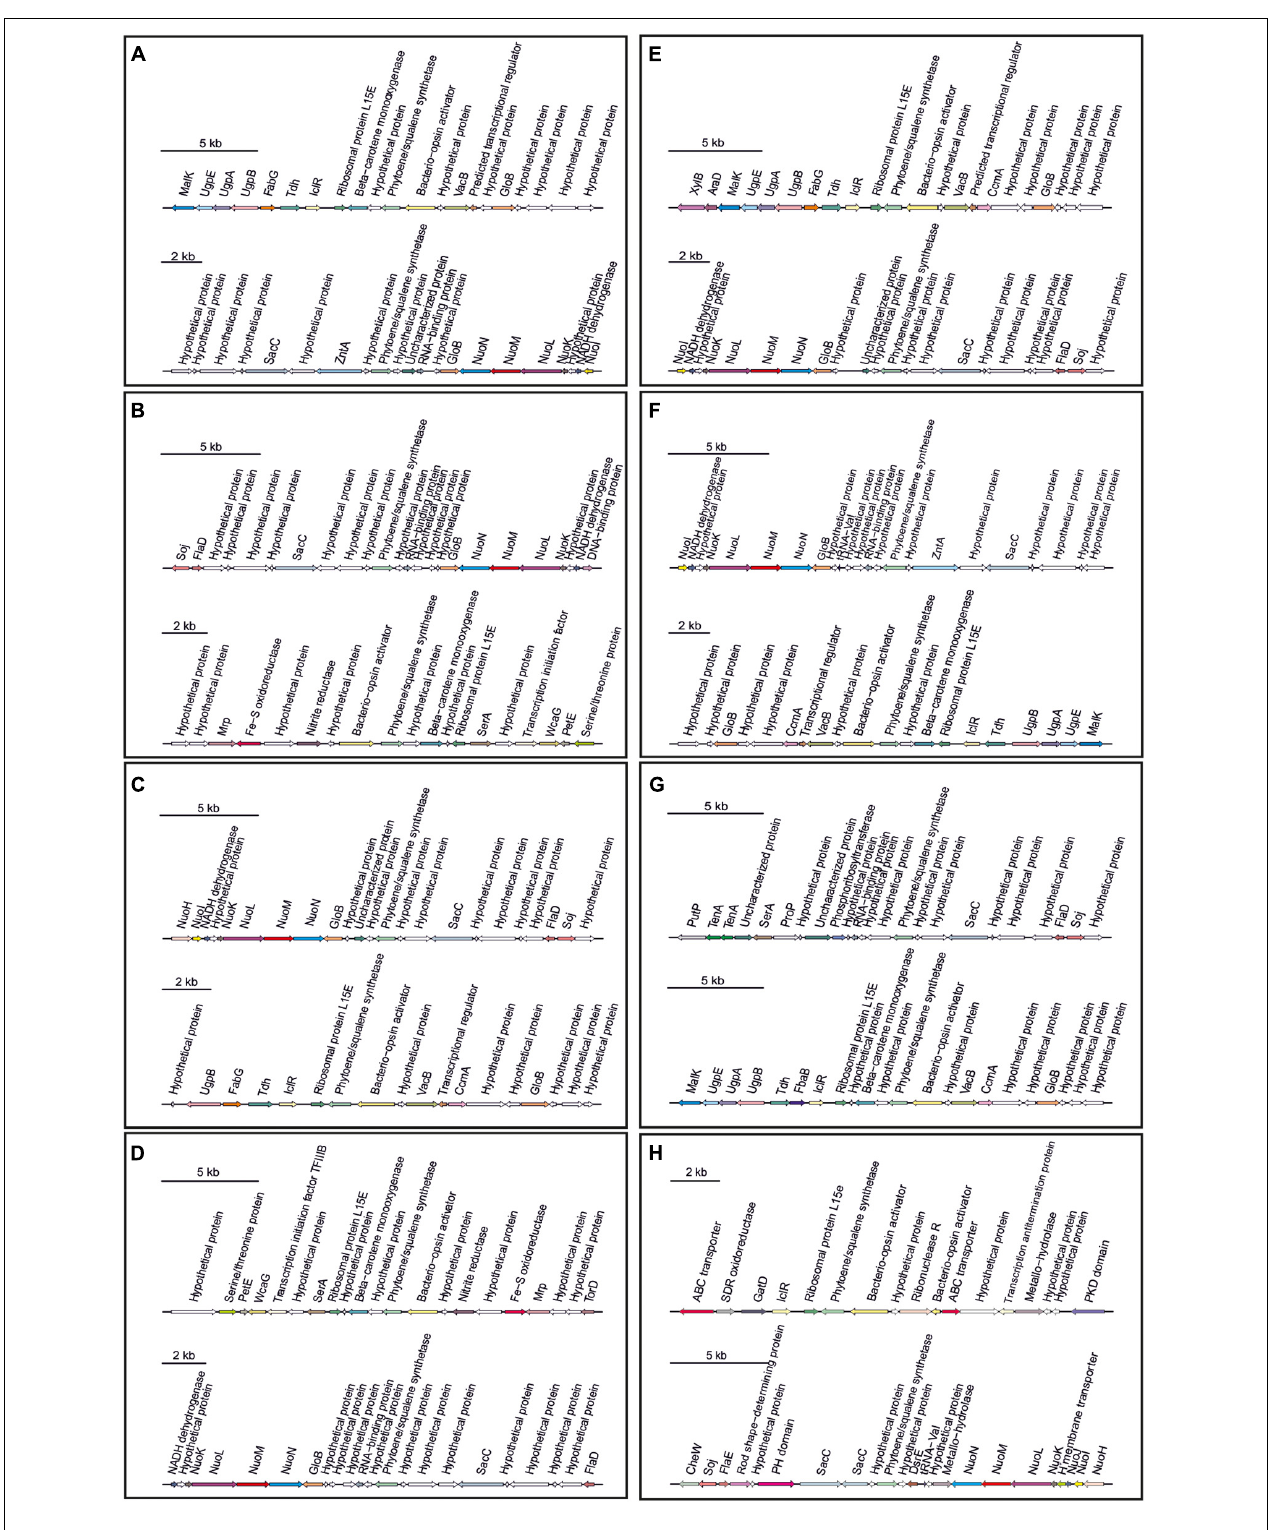
FIGURE 3 | Terpene biosynthetic gene clusters identified in Halomicroarcula genomes: (A) Strain F13 T , (B) Strain F24A T , (C) Strain F27 T , (D) Strain F28, (E) Halomicroarcula limicola JCM 18640 T , (F) Halomicroarcula pellucida CECT 7537 T , (G) Halomicroarcula salina JCM 18369 T , and (H) Halomicroarcula amylolytica LR21 T